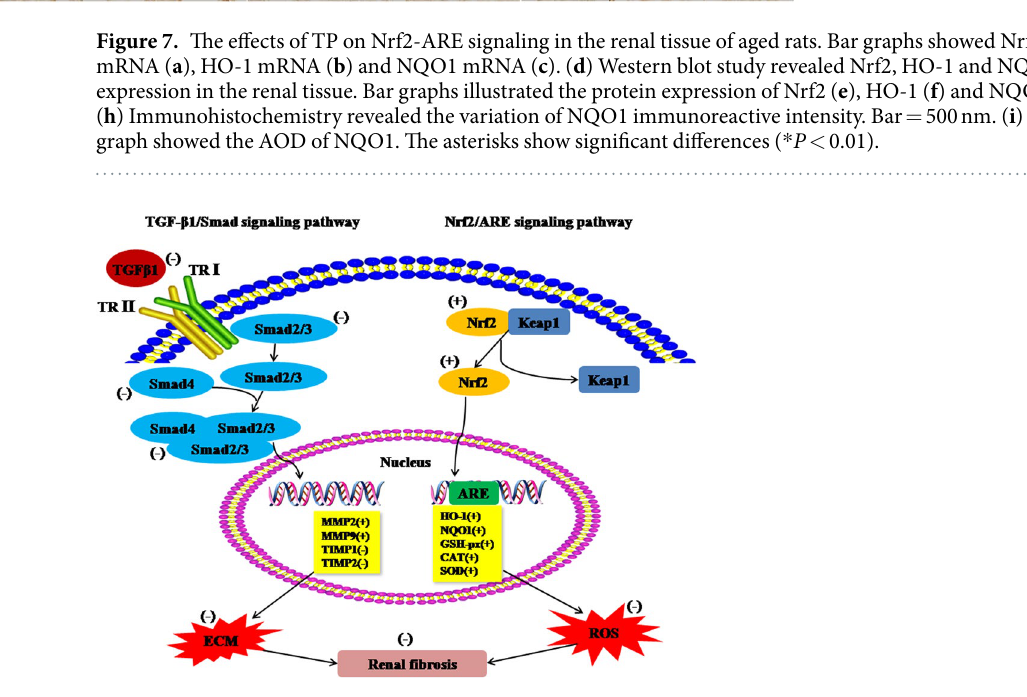
Figure 8. Regulatory effects of androgen on TGF- β 1/Smad signaling pathway and Nrf2-ARE signaling pathway. ( + ): positive effect; ( − ): negative